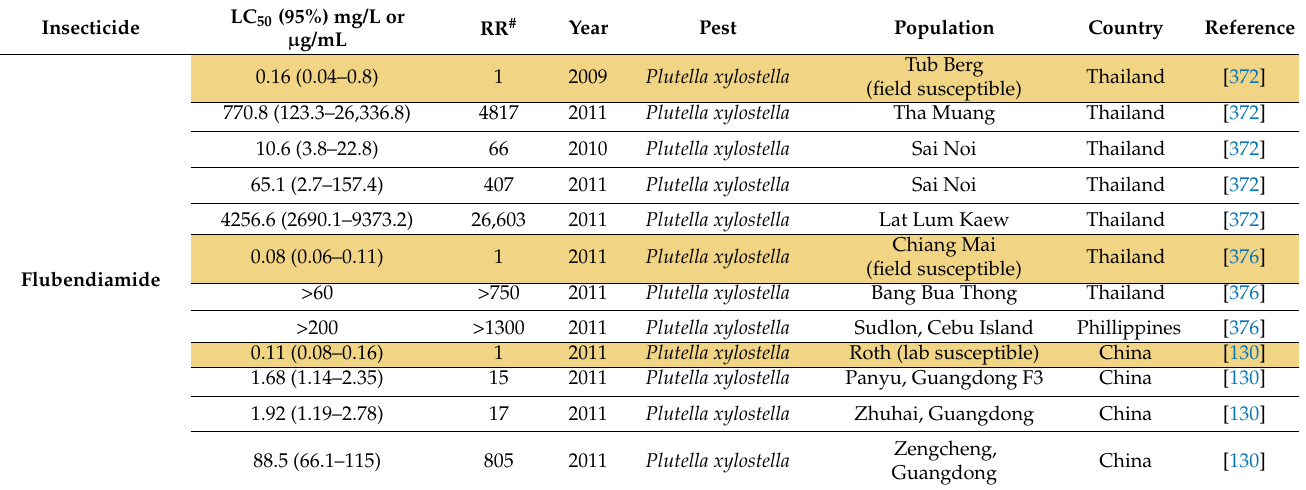
Table 3. Resistance developed by field-populations against diamides to